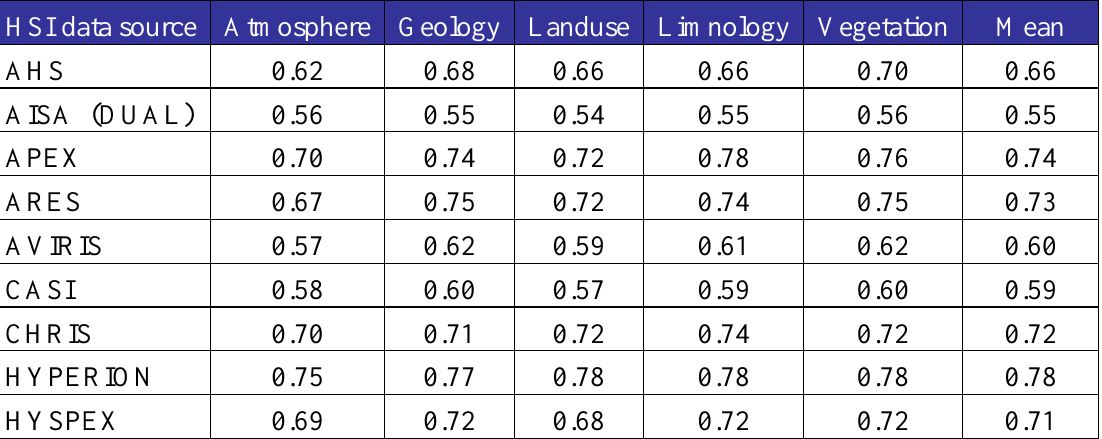
Table 2. Resulting overall relative values for different sensors and